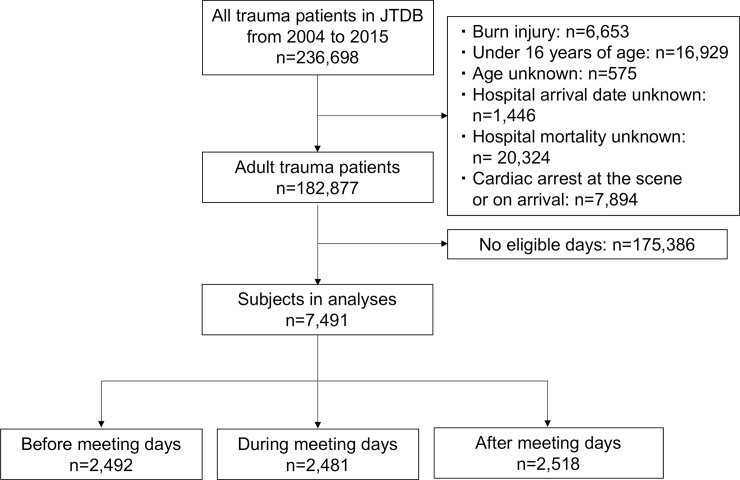
Flow diagram of the study population.JTDB, Japan Trauma Data Bank.